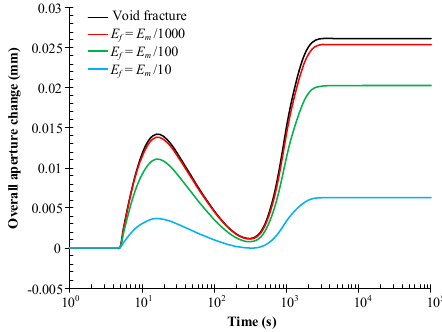
Figure 11. Evolution of fracture aperture change for different assumed fracture properties.